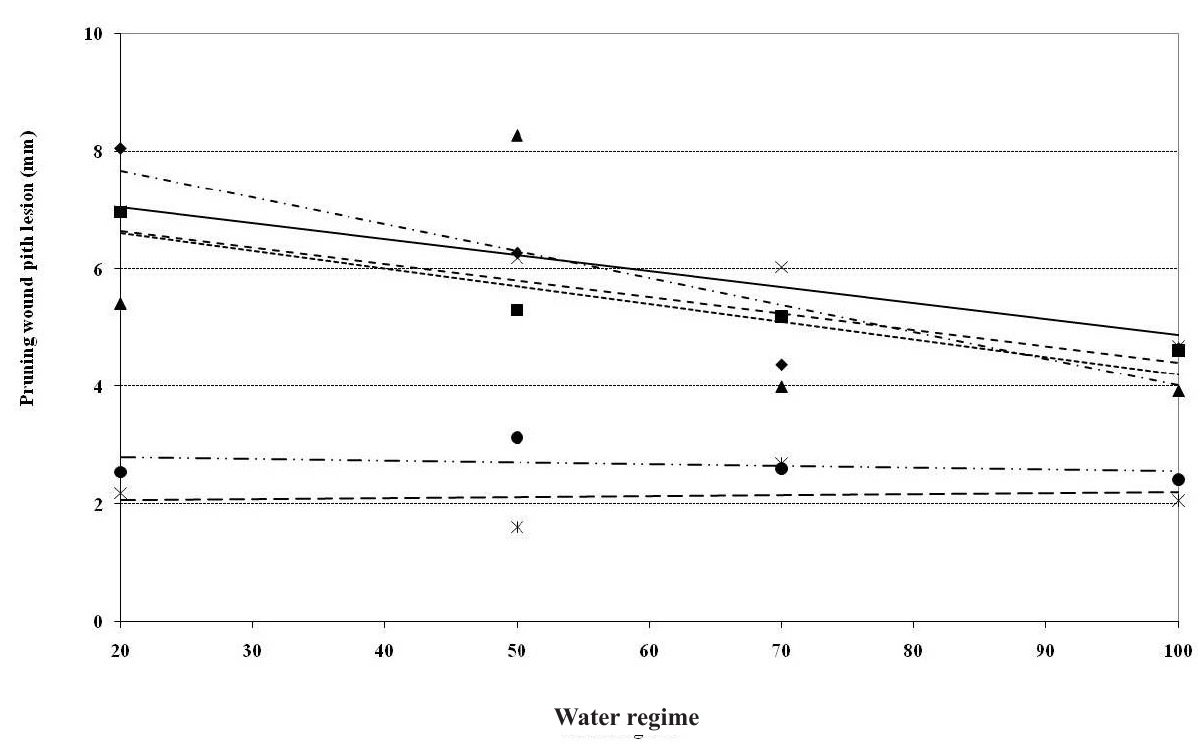
Figure 6. Linear regression lines [Eco-77 ( ▬ ▬ ▬ ), water ( ▬ ▪ ▪ ▬ ), L. theobromae ( ▬ ▬ ), N. australe ( ▬ ▪ ▬ ), N. parvum ( - - - ), D. seriata ( − − − )] fitted to the mean pruning wound pith lesions observed in the stems of potted grape- vines subjected to the control treatments, Eco-77 ( x ) or water ( ● ), or inoculated with N. australe ( t ), D. seriata ( ■ ), N. parvum ( ▲ ), L. theobromae ( x ) and receiving 20, 50, 70% and optimal (100%)